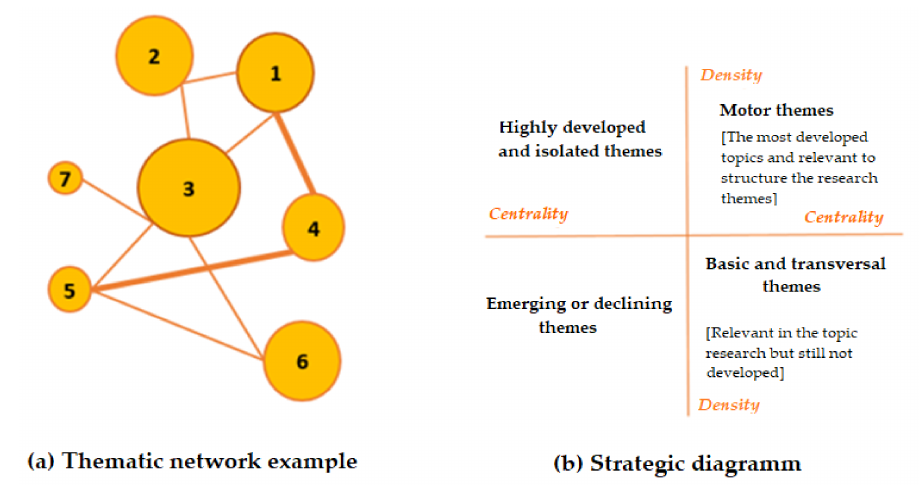
Figure 5. Thematic network ( a ) and strategic diagram ( b ). Source: adapted from